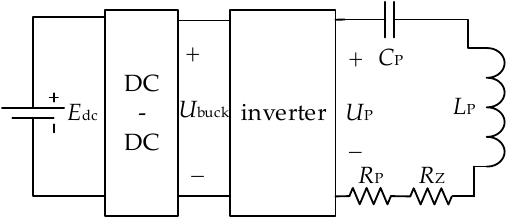
Figure 5. Equivalent circuit diagram of primary side.